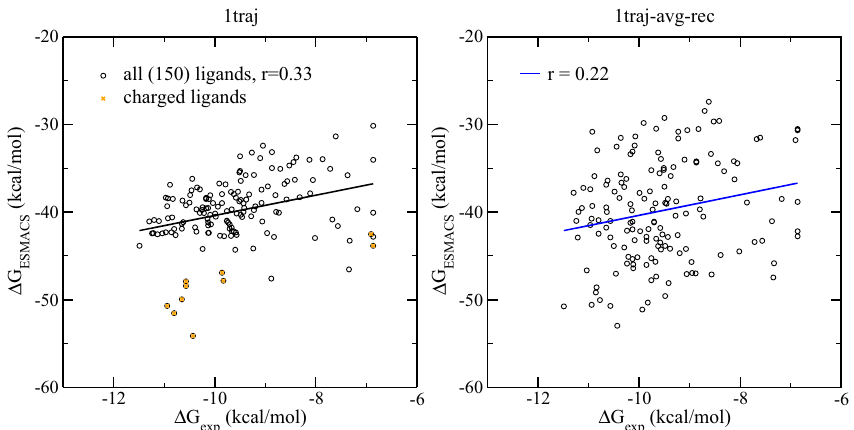
Figure 3. Comparison of calculated binding free energies and experimental binding affinity data from 1traj and 1traj-ar ESMACS approach. The charged compounds are shown in orange.